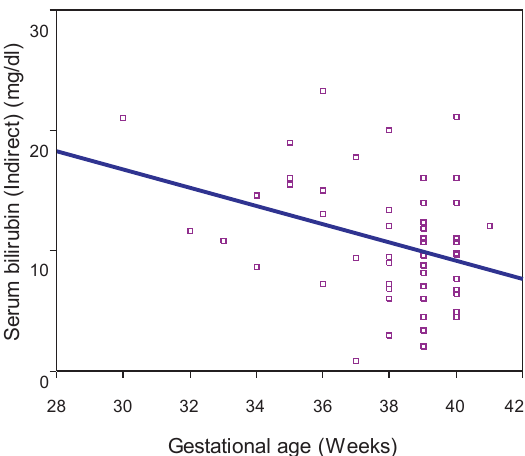
Fig 3. Correlation between gestational age and serum bilirubin